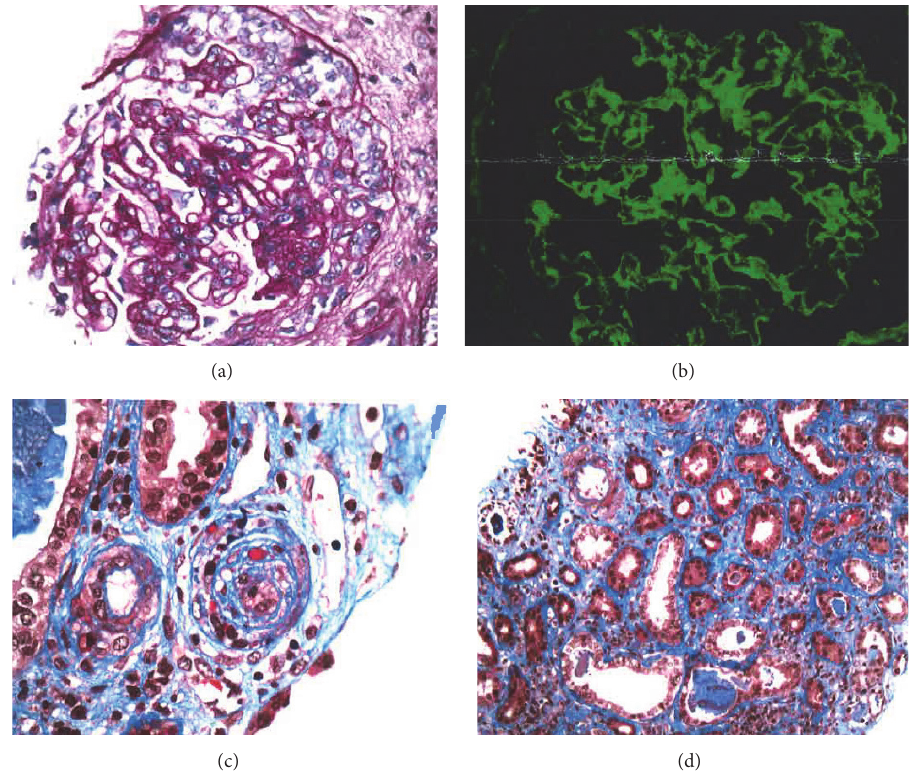
Figure 2: Renal biopsy with crescent formations (image (a)). Immunofluorescent findings (image (b)) of diffuse granular mesangial and glomerular capillary wall staining for IgG, IgM, IgA, C3, and C1; tubular basement membrane and arteriolar staining for IgG, IgM, and C3; vessel wall staining for IgG, IgM, and C3. Arterioles with focal luminal obliteration and concentric intimal fibroplasia (image (c)). Moderate fibrosis (image (d)). Findings consistent with lupus nephritis and severe